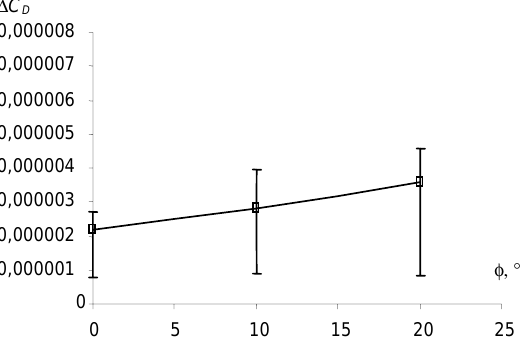
Fig 5 . Variation of average calculation error of wing lift force coefficient. NACA4415 wing Re=2,1 × 10 6 , AR=6,2